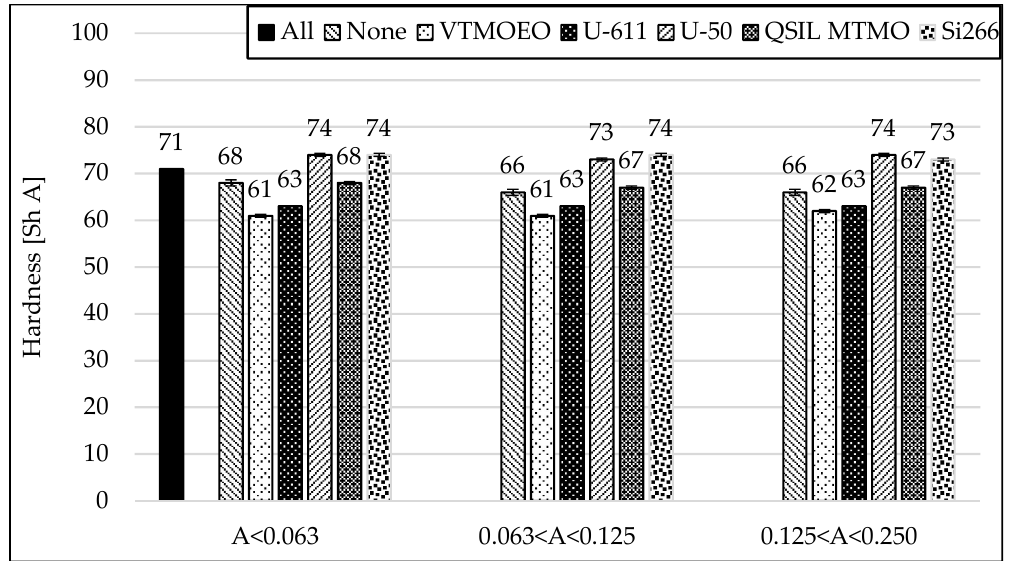
Figure 9. Influence of the silanization of fly ash with various silanes on mechanical properties: TS ( A ) and elongation at break ( B ) of the rubber vulcanizates filled with CB and different FA fractions.